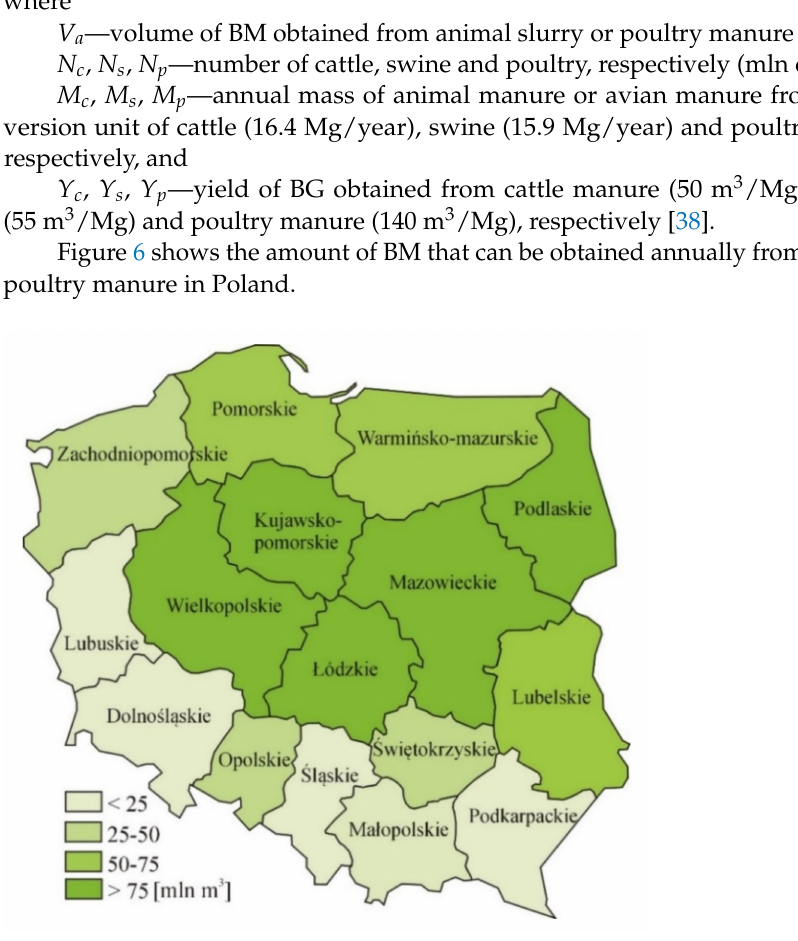
Figure 6. Volume of BM obtained from animal slurry or poultry manure in Poland (mln m 3 /year). The total volume of BM that can be obtained from animal slurry or poultry manure in Poland is 1071 mln m 3 . Most of the BM can be obtained in the Wielkopolskie Voivodship (238 mln m 3 ), in the Mazowieckie Voivodeship (178 mln m 3 ), in Podlaskie Voivodship (120 mln m 3 ), in the Kujawsko-Pomorskie Voivodeship (93 mln m 3 ) and in the Ł ó dzkie Voivodeship (89 mln m 3 ). There are the largest number of large livestock farms in these voivodships; therefore, the construction of BM plants in these areas is most